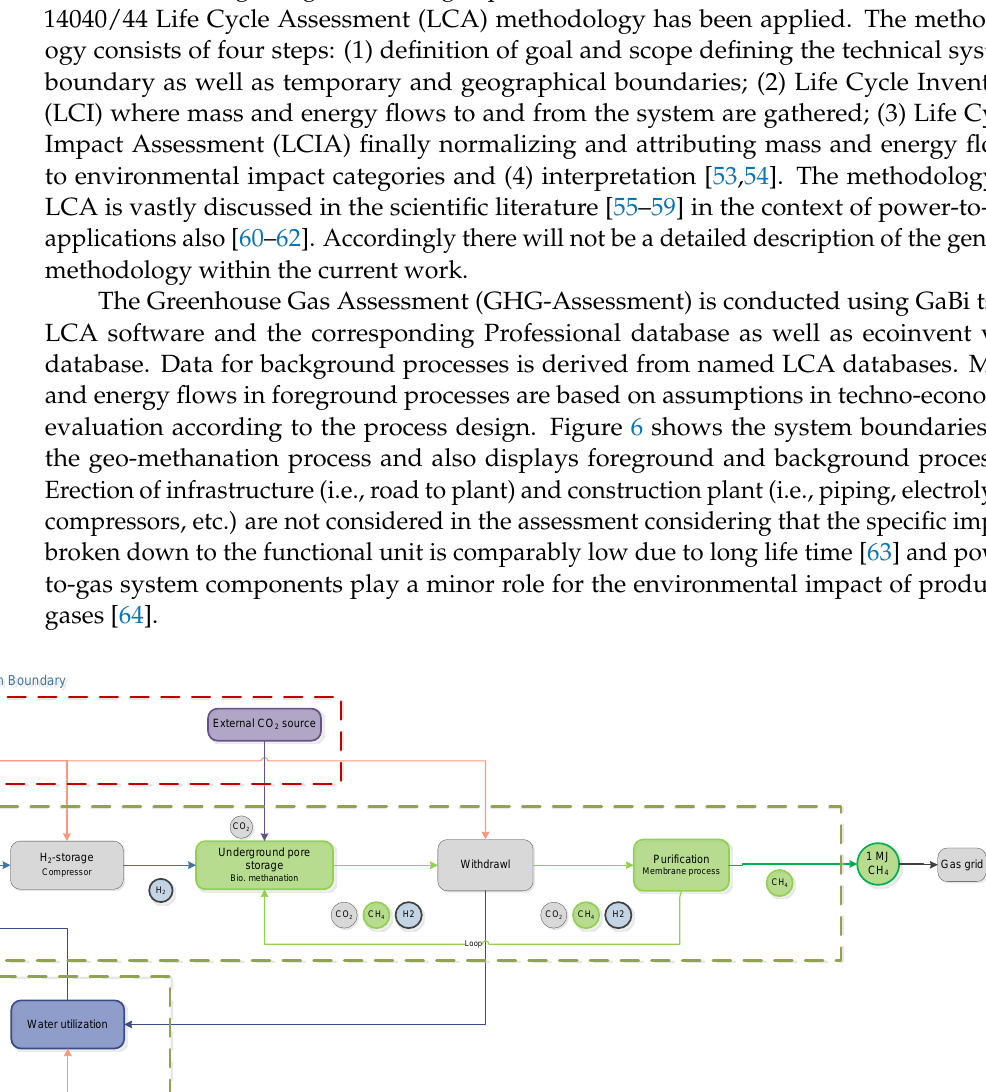
Figure 7. Gas composition (proportion of CH 4 , H 2 and CO 2 ) during injection and withdrawal. As the mass balance shows, a significant amount of gas is kept in the loop and in- jected again to the underground pore storage. The operating energy used for geo-